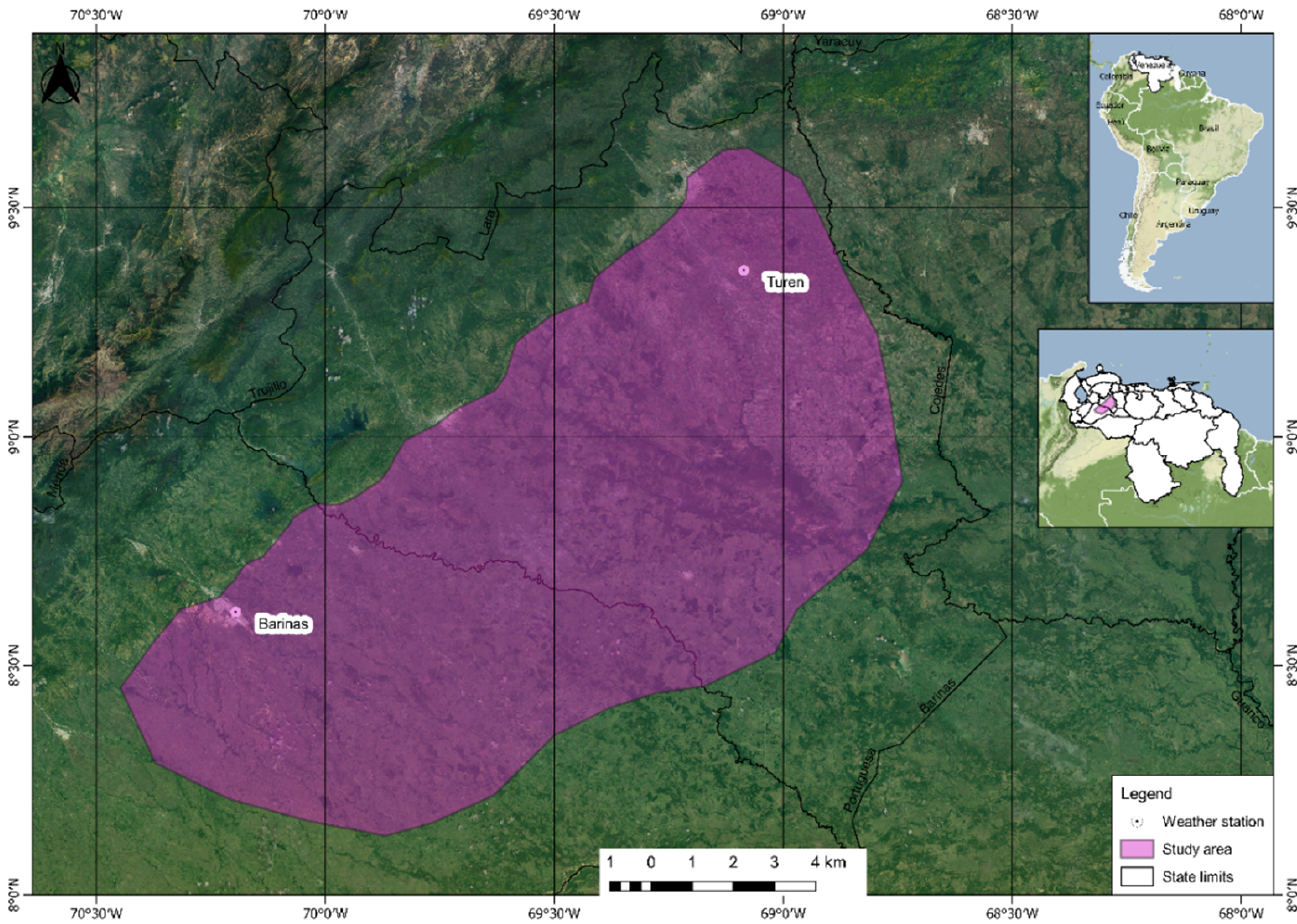
Figure 1. Weather station locations: Barinas and Turen in the western plain region of Venezuela.